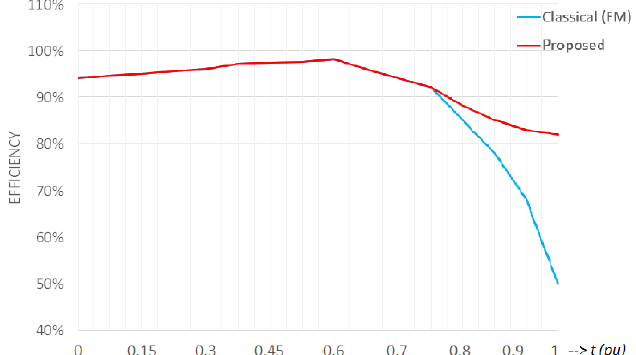
Figure 20. Efficiency comparison of classical vs proposed methods.